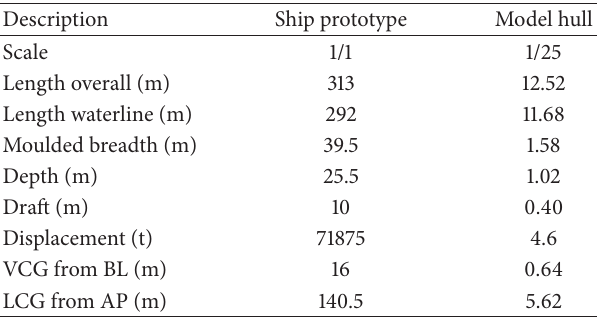
Table 1: Principal